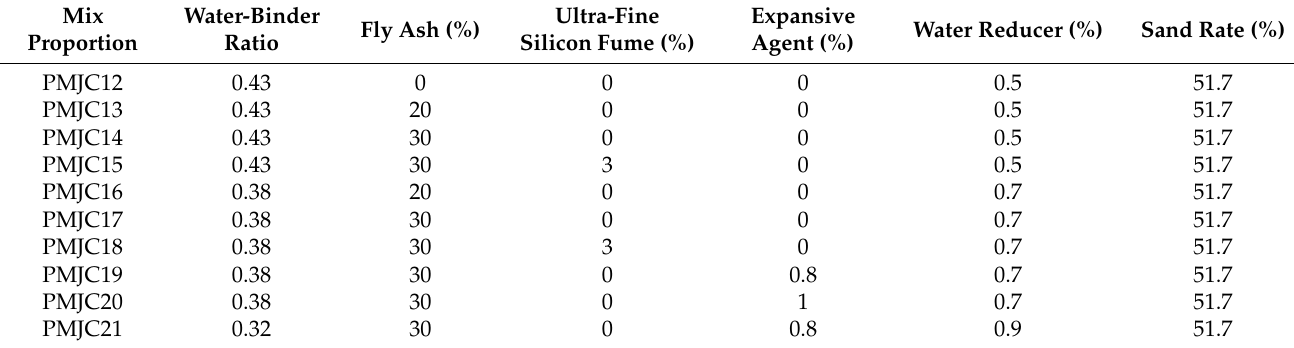
Table 10. Mix proportion of the non-contact autogenous shrinkage